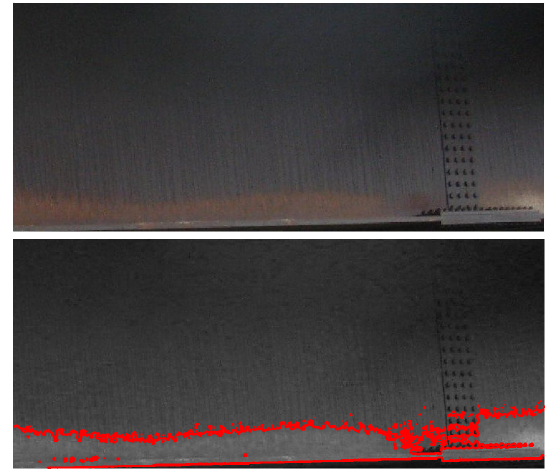
Figure 5: Road bridge located in Perarolo di Cadore considered in as test case in this work.